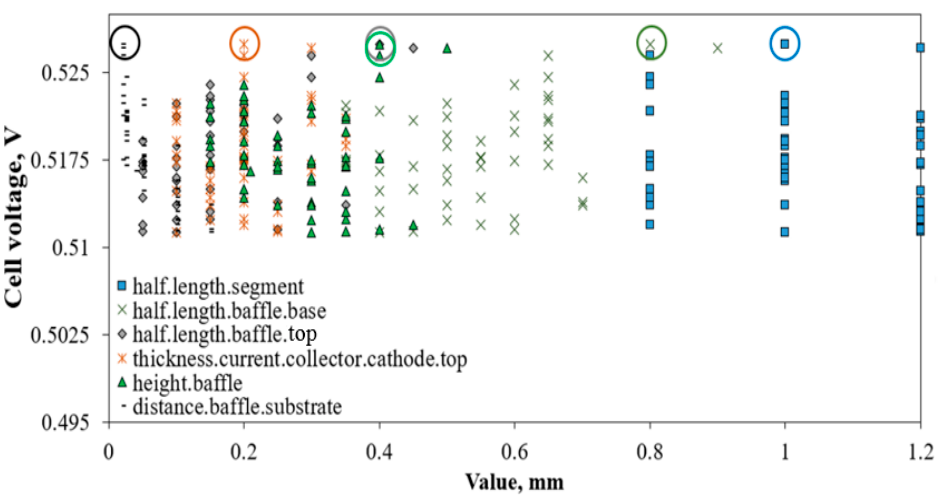
Figure 11. Influence of every parameter on the electric potential of the cell at a current density of 4.0 A·cm − 2 .